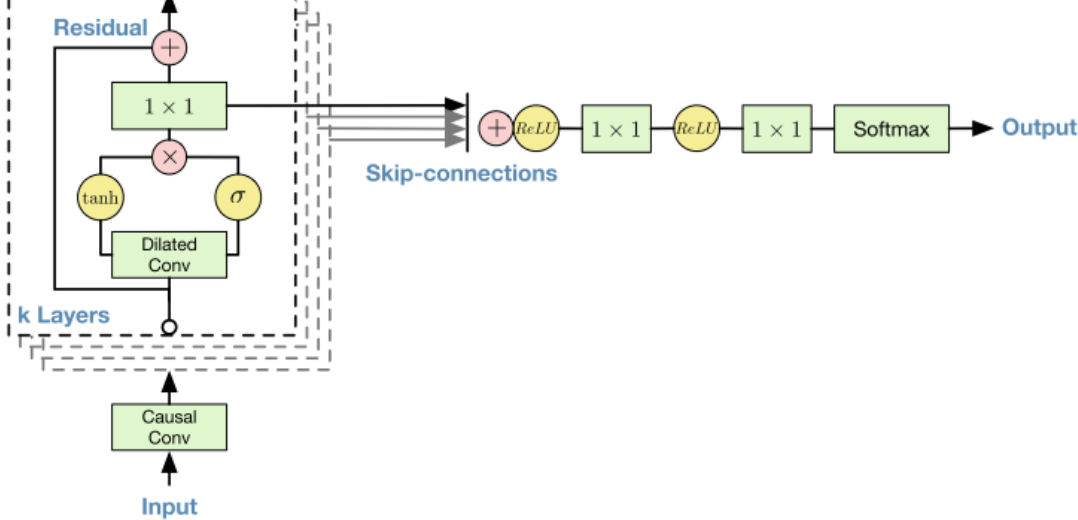
Figure 1. Original WaveNet architecture presented by DeepMind in [26].